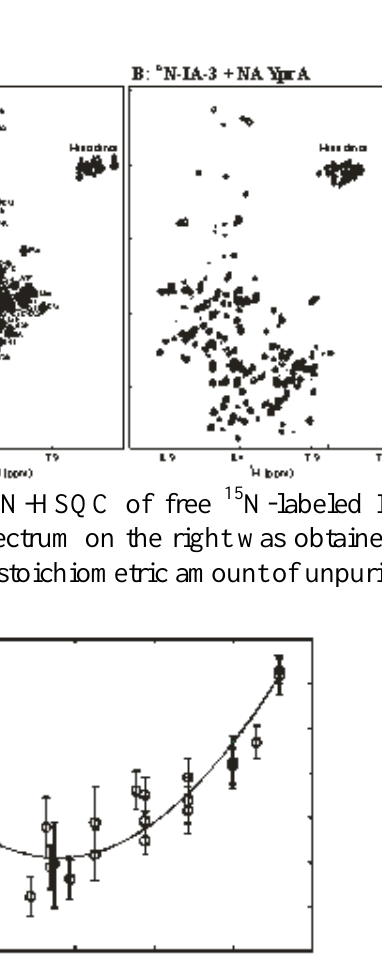
FIGURE 2. van’t Hoff plot of the inhibition of YprA by IA analysis of the data generates the fit shown, which indicates a positive van’t Hoff enthalpy ∆ H(T = H (T ) – H (T ) = 76 ± 9 kJ/mol and ∆ Cp = – 4.6 ± 1.2 kJ/mol-K, at a bound 0 unbound 0